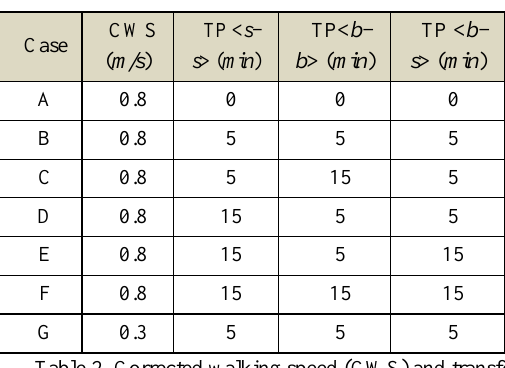
Table 2. Corrected walking speed (CWS) and transfer penalties (TP) for different cases